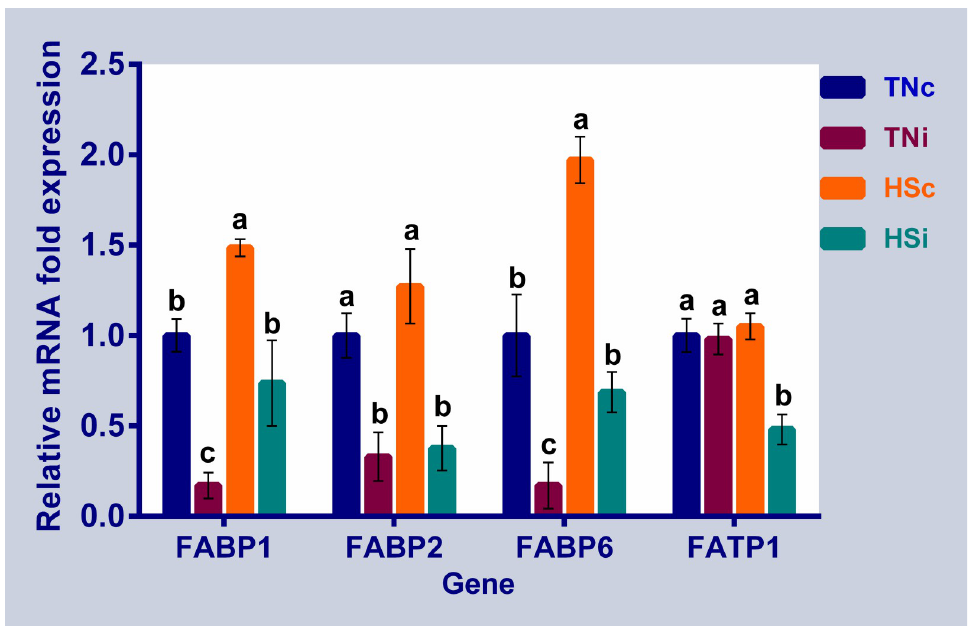
Fig 5. The mRNA expression of the ileal fatty acid transporters. The mRNA fold expression of the ileal fatty acid transporters at 6 dpi of chickens infected with E . maxima and their uninfected controls that are raised in a thermoneutral or heat stress environment: TNc = thermoneutral control, TNi = thermoneutral infected, HSc = heat stress control, HSi = heat stress infected. Significant differences (p < 0.05) were depicted by different letters. The error bars represent the